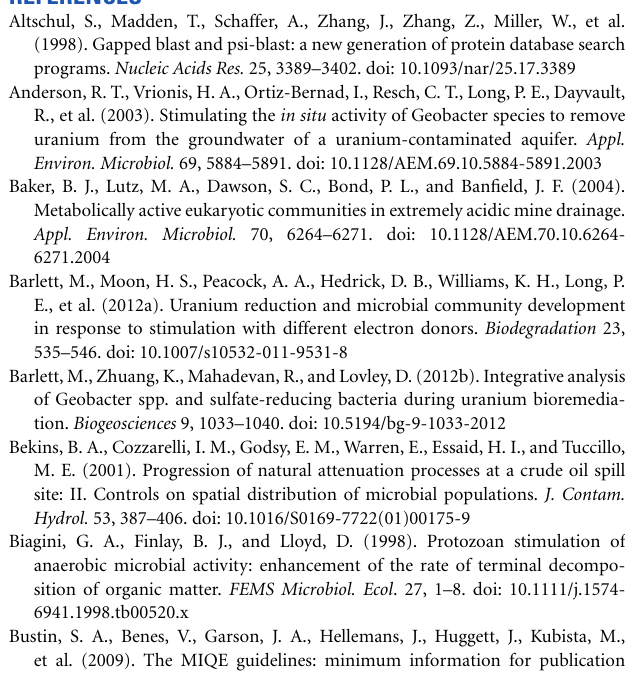
cycloheximide and colchicine; (C) The number of Methanomicrobiales mcrA and Metopus ß-tubulin gene copies detected in groundwater collected from sediment